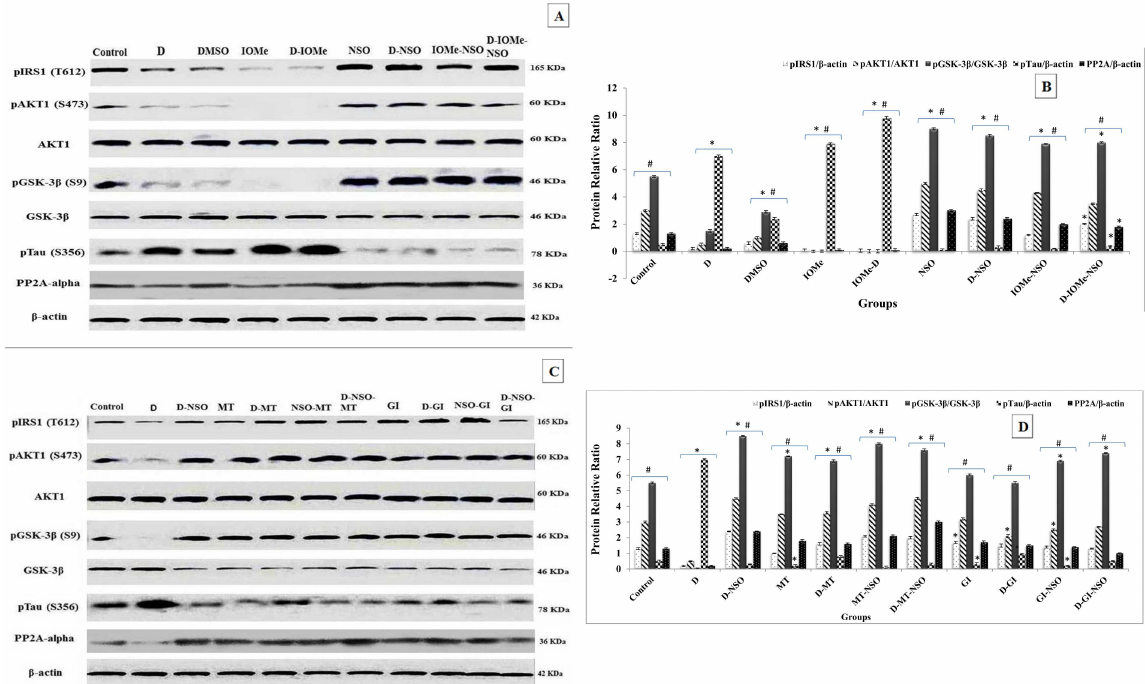
Fig 3. Representative western blotting analysesof brain insulin-induced signaling molecules. Protein level profile of p- IRS1-Tyr612 was normalized to the total amount of β -actin protein and p-AKT1-Ser473 level was normalized to the total amount of AKT1. p-GSK3 β -Ser9 was normalized to the total amount of GSK3 β . p-Tau-Ser356 and PP2A-alpha levels were normalized to the total amount of β -actin protein in the brain tissue of diabeticrats injected with IOMe and treated with NSO (A). Protein profile of diabetic rats after the treatment with NSO, anti-diabeticdrugs and combination therapy is shown as (C). The quantification of protein bandsis represented as mean ± SE (n = 5/group)(B) and (D).